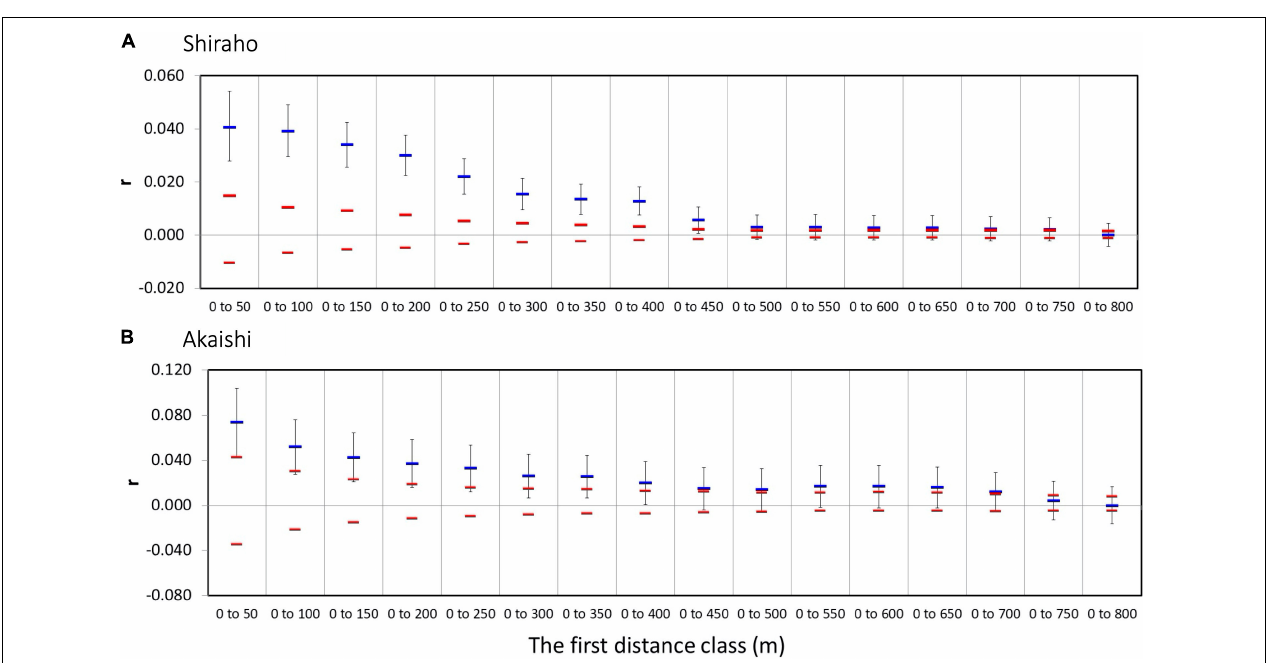
individuals was improved by increasing the number of loci